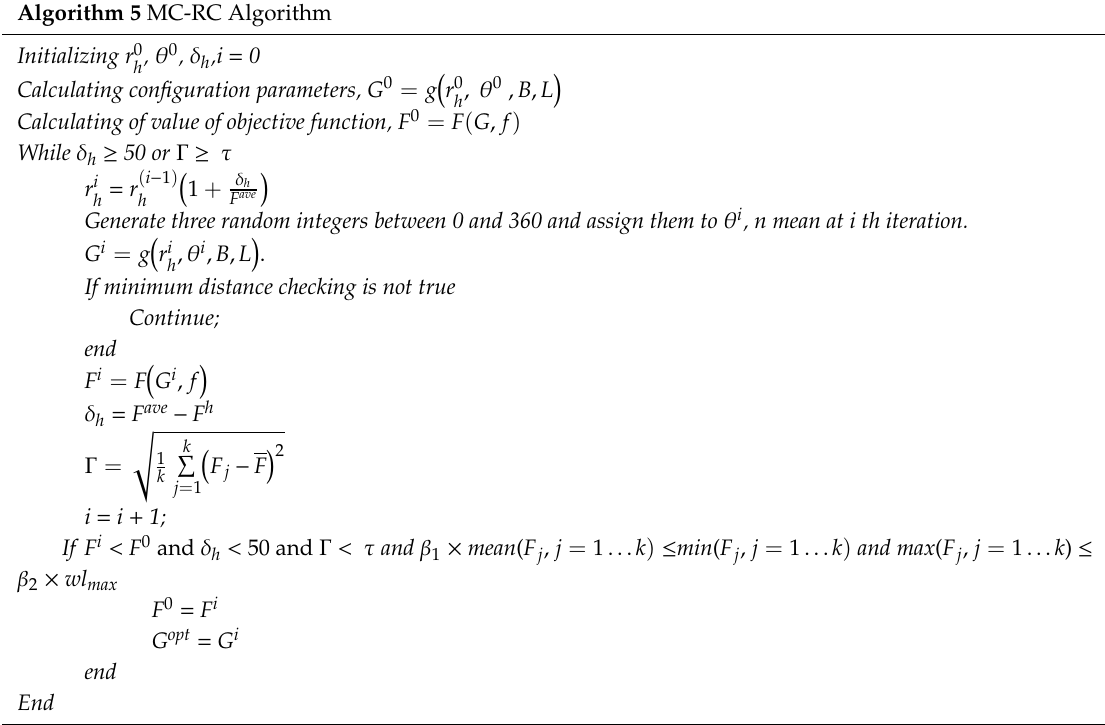
Algorithm 5 MC-RC Algorithm